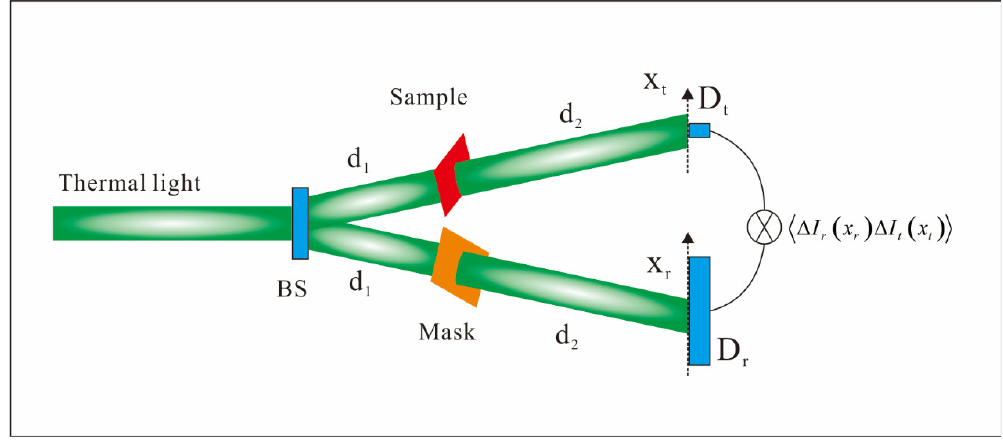
Figure 5. Principle of X-ray Fourier-transform GISC with coded diffraction patterns